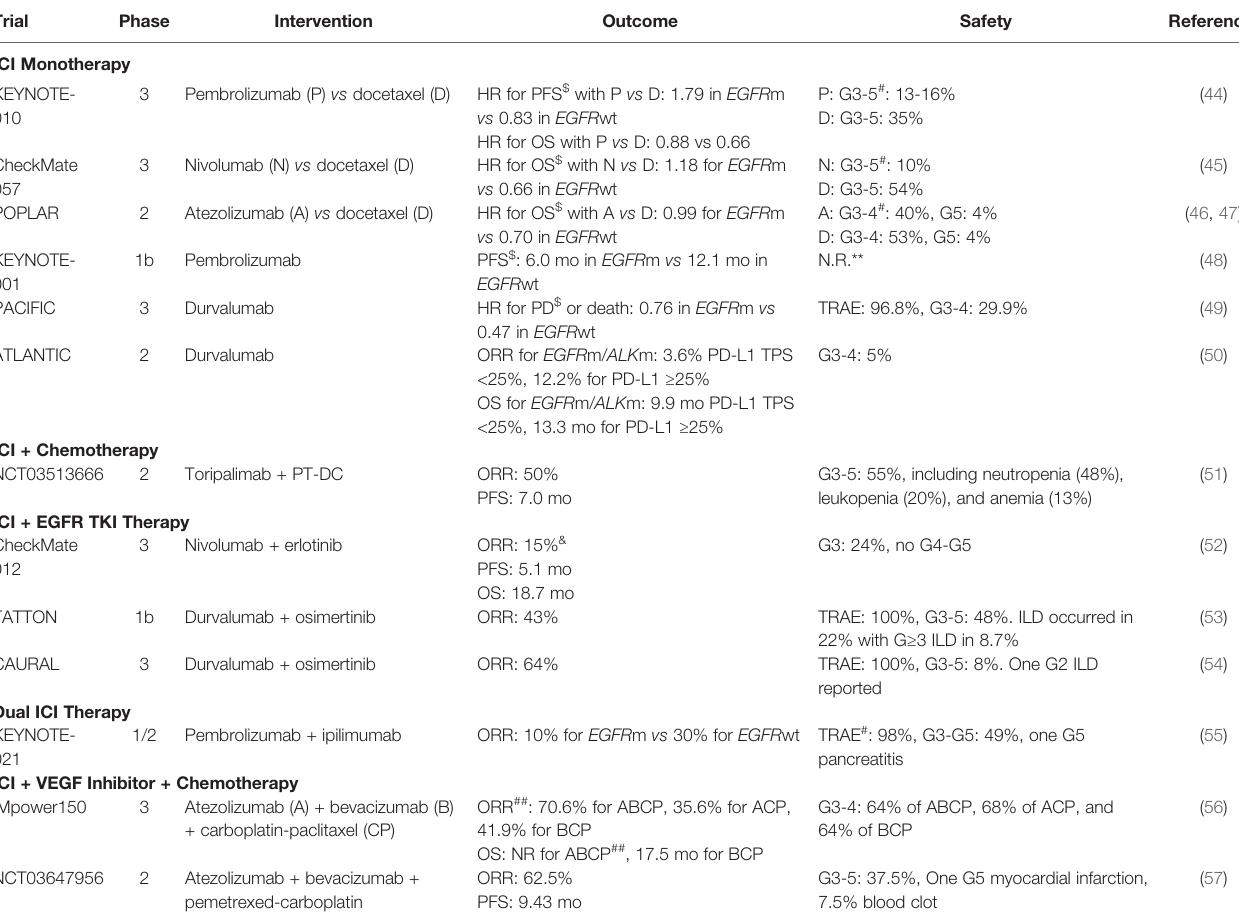
TABLE 2 | Second-line or later ICI Clinical Trials in EGFR m